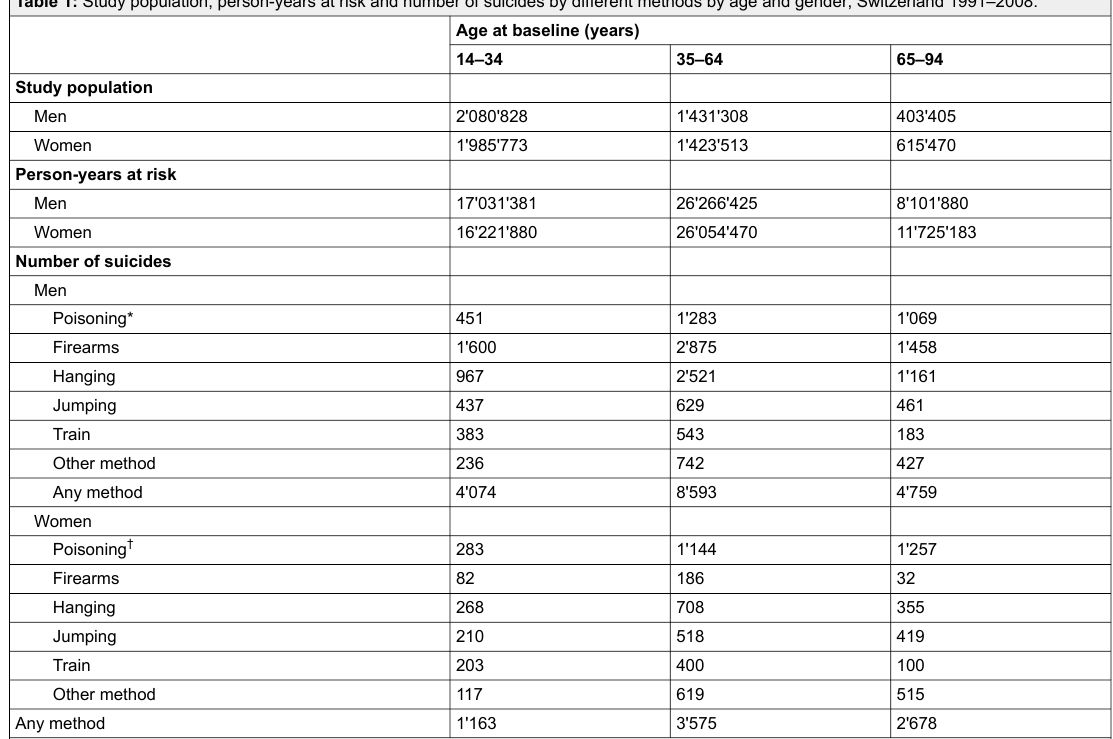
Table 1: Study population; person-years at risk and number of suicides by different methods by age and gender; Switzerland